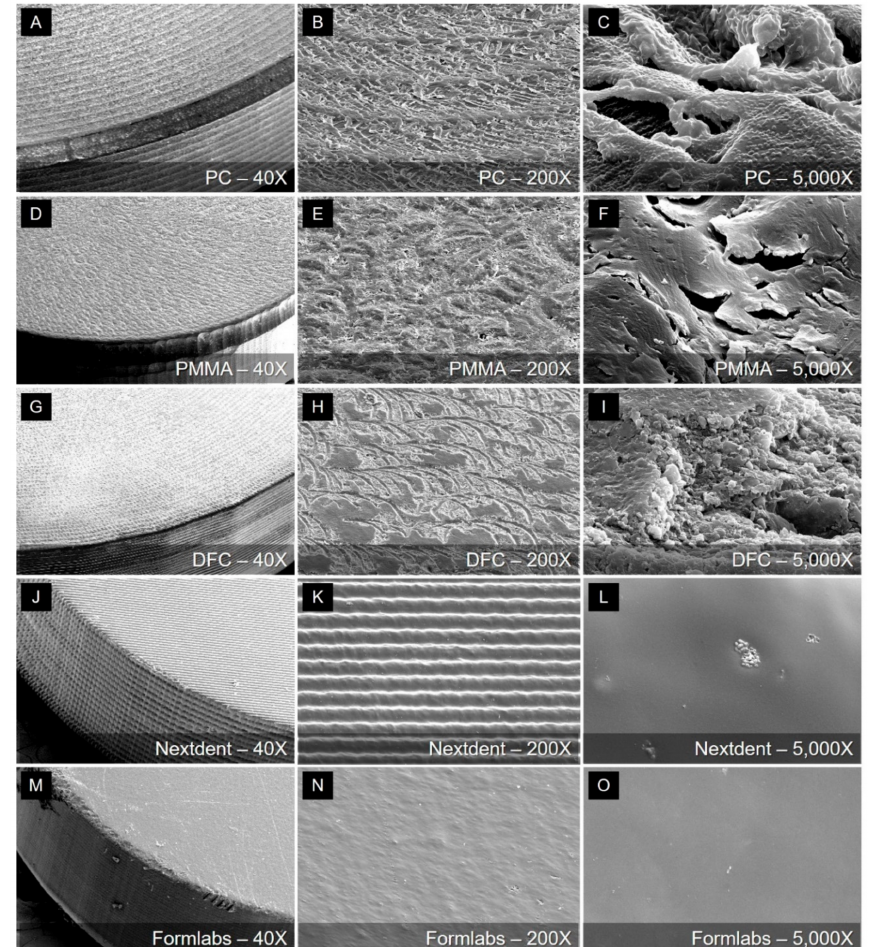
Figure 5. Qualitative scanning electron images of the surface topography of five restorative material specimens at ( A , D , G , J , M ) 40 × , ( B , E , H , K , N ) 200 × , and ( C , F , I , L , O ) 5000 × magnifications. ( A – I ) Traces of bur passes were found on the surface of the specimen manufactured by the milling method. ( J – L ) Specimens of the Nextdent group made with a digital light processing 3D printer, and ( M – O ) Specimens of the Formlabs group made with a stereolithography 3D